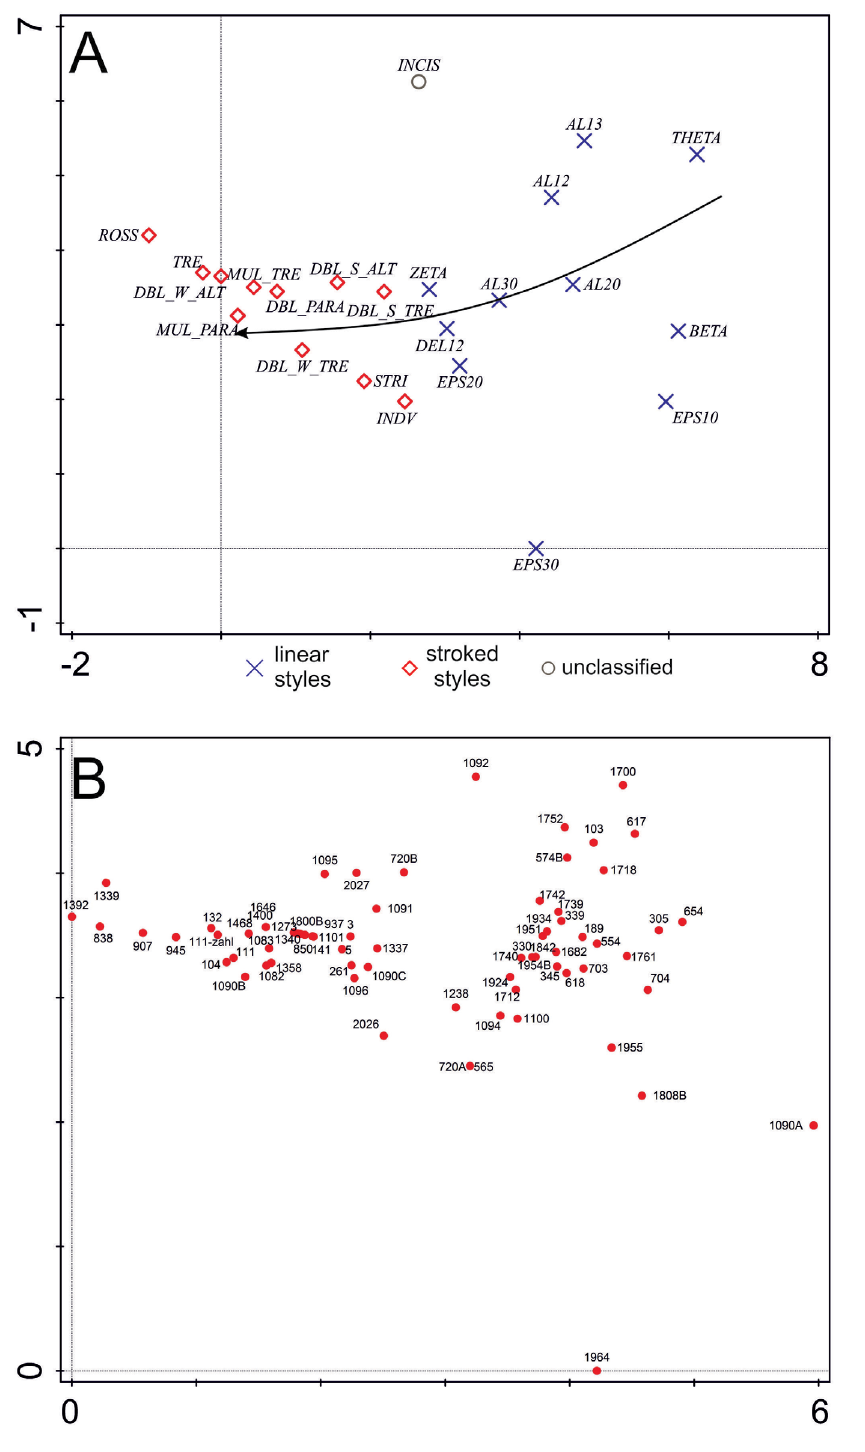
Figure 3. Detrended correspondence analysis of decoration styles (A) and Neolithic sunken features (B). The first axe explains 17.9 %, the second 10.7 % of the variability. The arrow indicates chronological gradient. For styles abbreviations see Figure